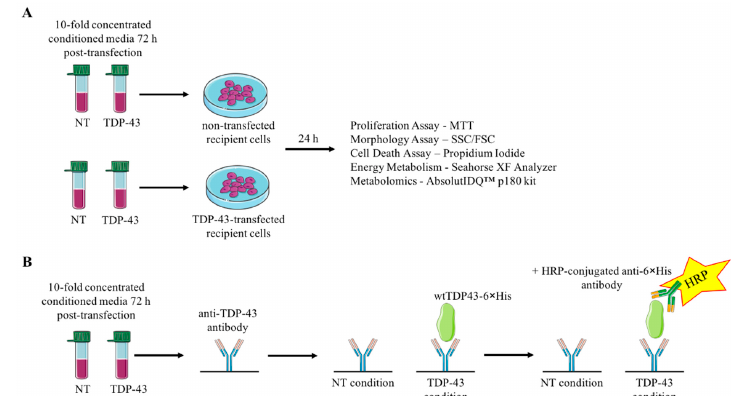
Figure 1. General workflow of the overall study. ( A ) Media from HEK-293T (Human Embryonic Kidney 293T) either non-transfected or transfected with wilde-type trans-active response DNA-binding protein-43 (wtTDP-43) were recovered after 72 h of overexpression. They were concentrated 10-fold by centrifugation and applied to naïve or TDP-43-overexpressing HEK-293T 24 h post-transfection. After 24 h of incubation, the assays mentioned in the figure were performed on the naïve recipient cells. ( B ) Protocol to measure the presence of overexpressed histidine-tagged wtTDP43 (wtTDP-43-6 × His) in conditioned medium by ELISA (enzyme-linked immunosorbent assay). Briefly, HEK-293T cells were either treated with transfection agent only or transfected with wtTDP43-6 × His cDNA. After 72 h, the media were recovered and concentrated 10-fold. These media were then applied to the sandwich ELISA. NT: Only addition of transfection agent; SSC: side scatter; FSC: forward